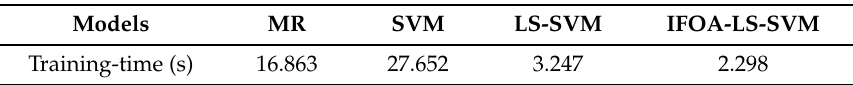
Table 5. Training ‐ time comparison between SVR, LS ‐ SVM and IFOA ‐ LS ‐ SVM models.